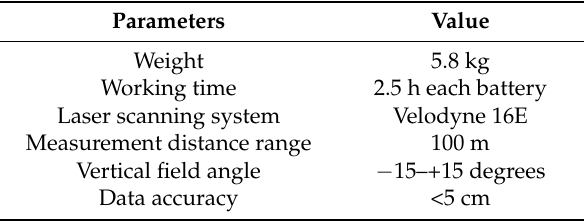
Table 3. Specifications of the backpack laser scanning